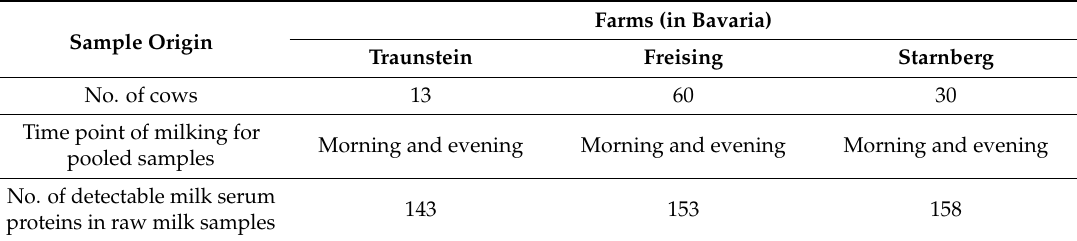
Table 1. Sources of raw